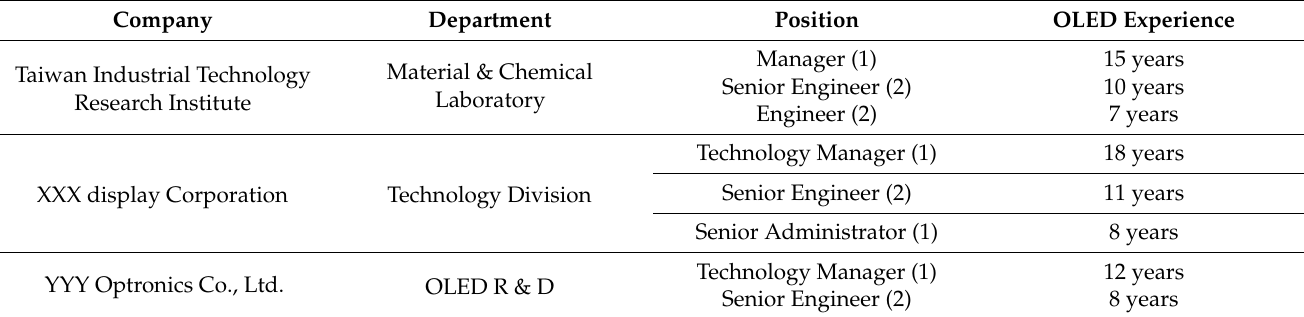
Table 5. Twelve Experts’ backgrounds.